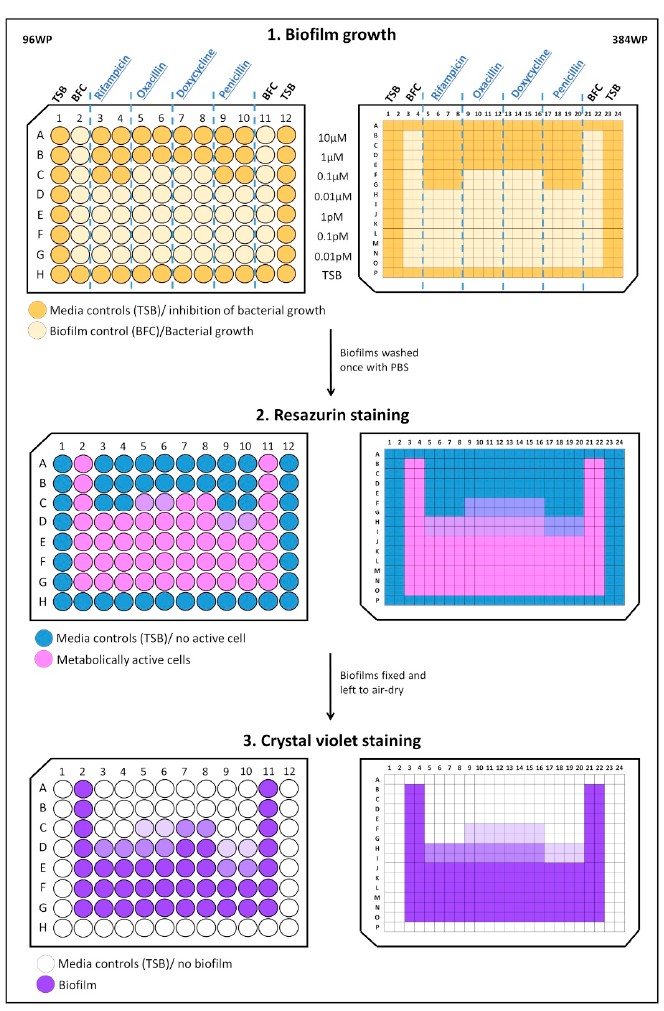
Scheme 1. Workflow used for comparing the inhibition of S. aureus growth with a panel of four model antibiotics using the pre-exposure mode in 96WP and